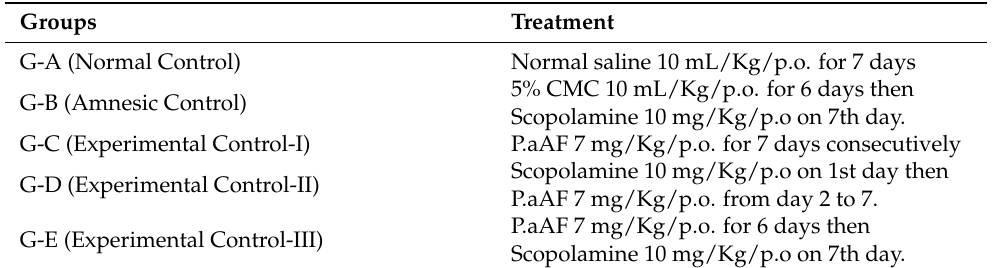
Table 8. Study design for estimation of choline acetyltransferase (ChAT) levels in mice brains.